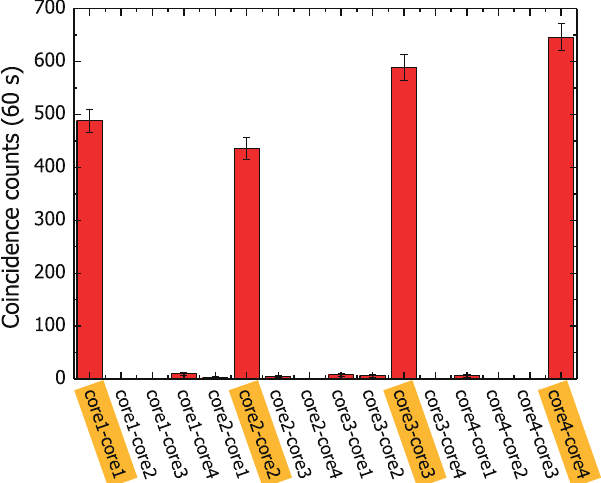
Figure 2. Correlations between the core modes (core i -core j : projection to core i of MCF1 and core j of MCF2).